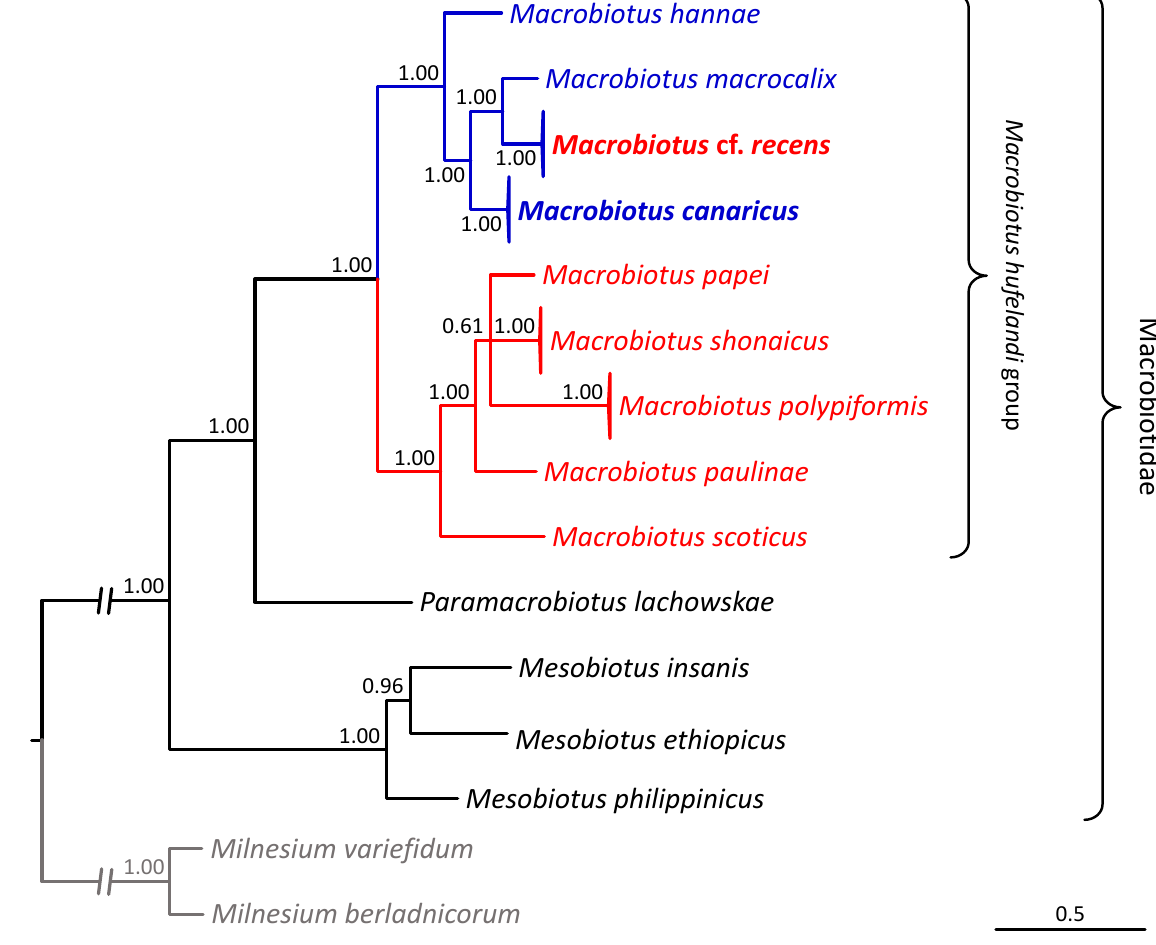
Fig. 16. The Bayesian Inference (BI) phylogeny constructed from concatenated sequences (18S rRNA + 28S rRNA + ITS-2 + COI) of the family Macrobiotidae. Numbers at nodes indicate the Bayesian posterior probability. Species of the hufelandi group with typical and atypical egg processes are indicated by blue and red fonts, respectively. See Table 2 and the Phylogenetic analysis subsection in Material and methods for details on the species sequences used in the analysis. The remaining macrobiotids are marked with black and the outgroup is marked with grey. The scale bar represents substitutions per